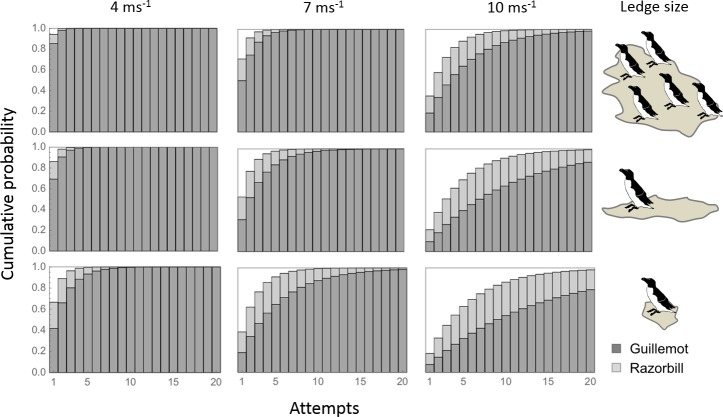
The cumulative probability of landing according to wind speed, ledge type and species.Seasonal wind speeds near the breeding cliffs will vary with wind direction and colony location (Figure 1—figure supplement 1 ). For the prevailing SW wind direction, median wind speeds across the breeding season are predicted to be ≤7 m s−1 (first two columns). Upper quartile speeds are predicted to be ≤ 9 m s−1 (third column), and reasonable maxima ≤ 16 m s−1.